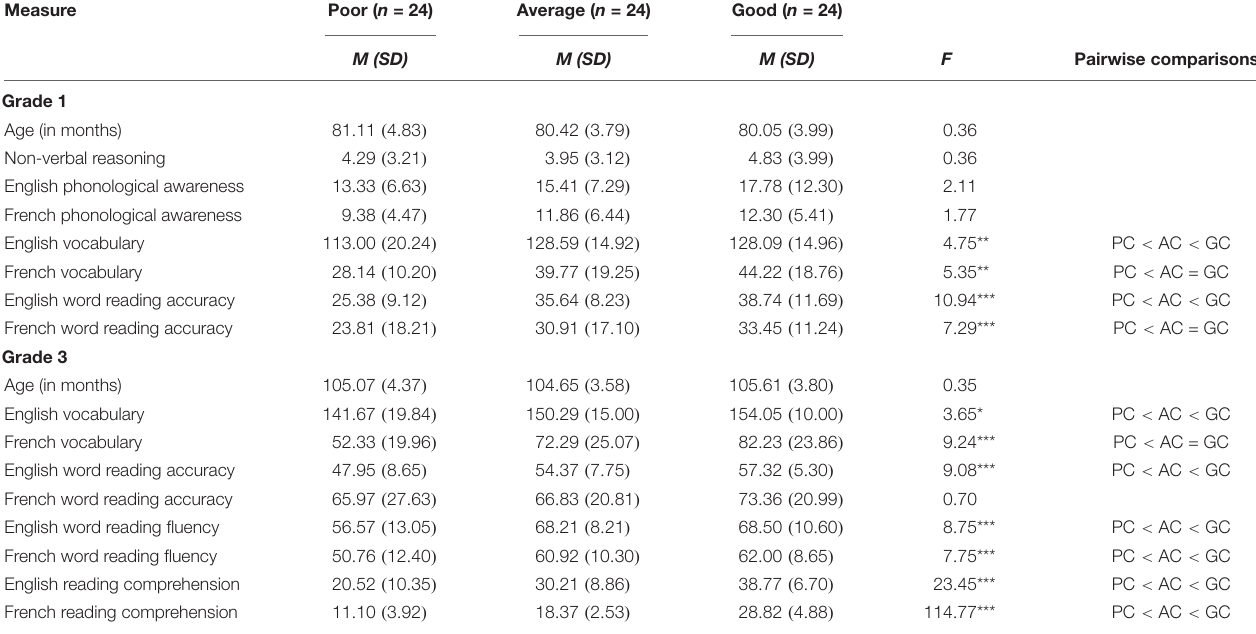
TABLE 3 | Means (standard deviations) of poor, average, and good comprehenders selected with French measures on English and French reading and language variables in grade 1 and grade